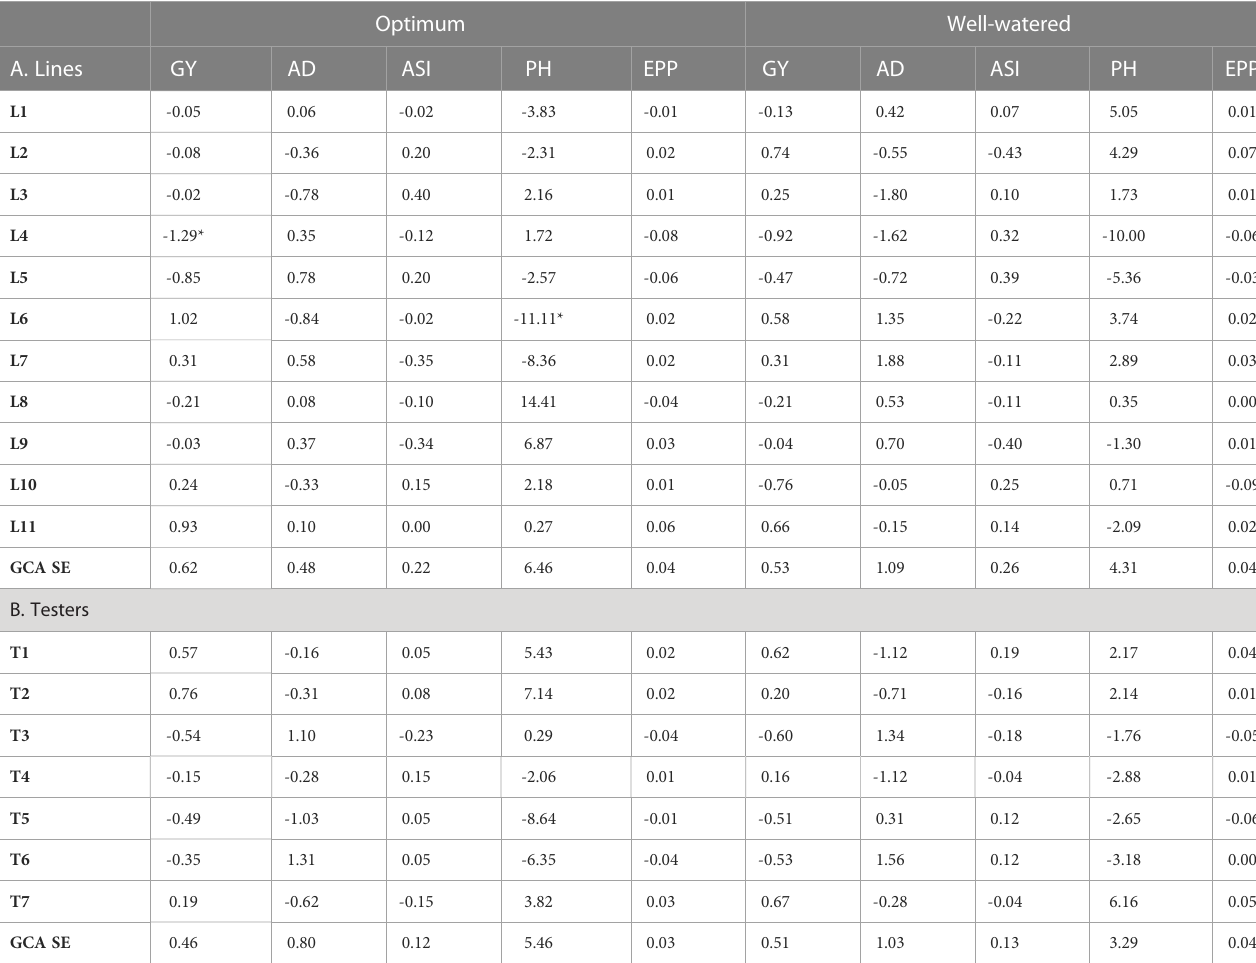
TABLE 7 Estimates of lines and tester GCA effects for grain yield and other agronomic traits under optimum and well-watered